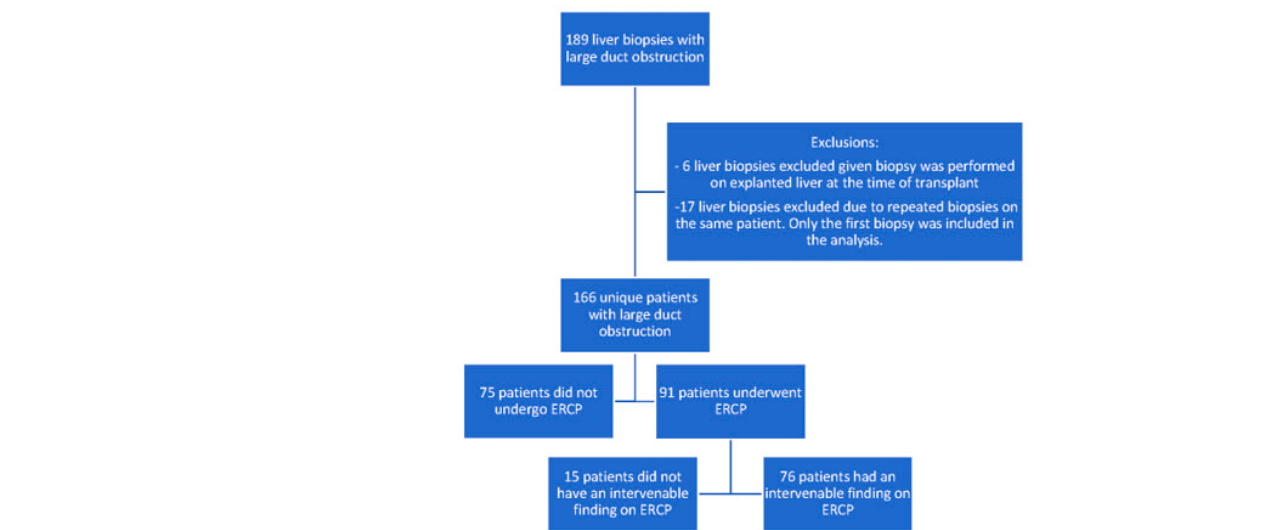
Figure 1. Study flow diagram. Table 1. Demographics and clinical characteristics of all adult patients with large duct obstruction on liver